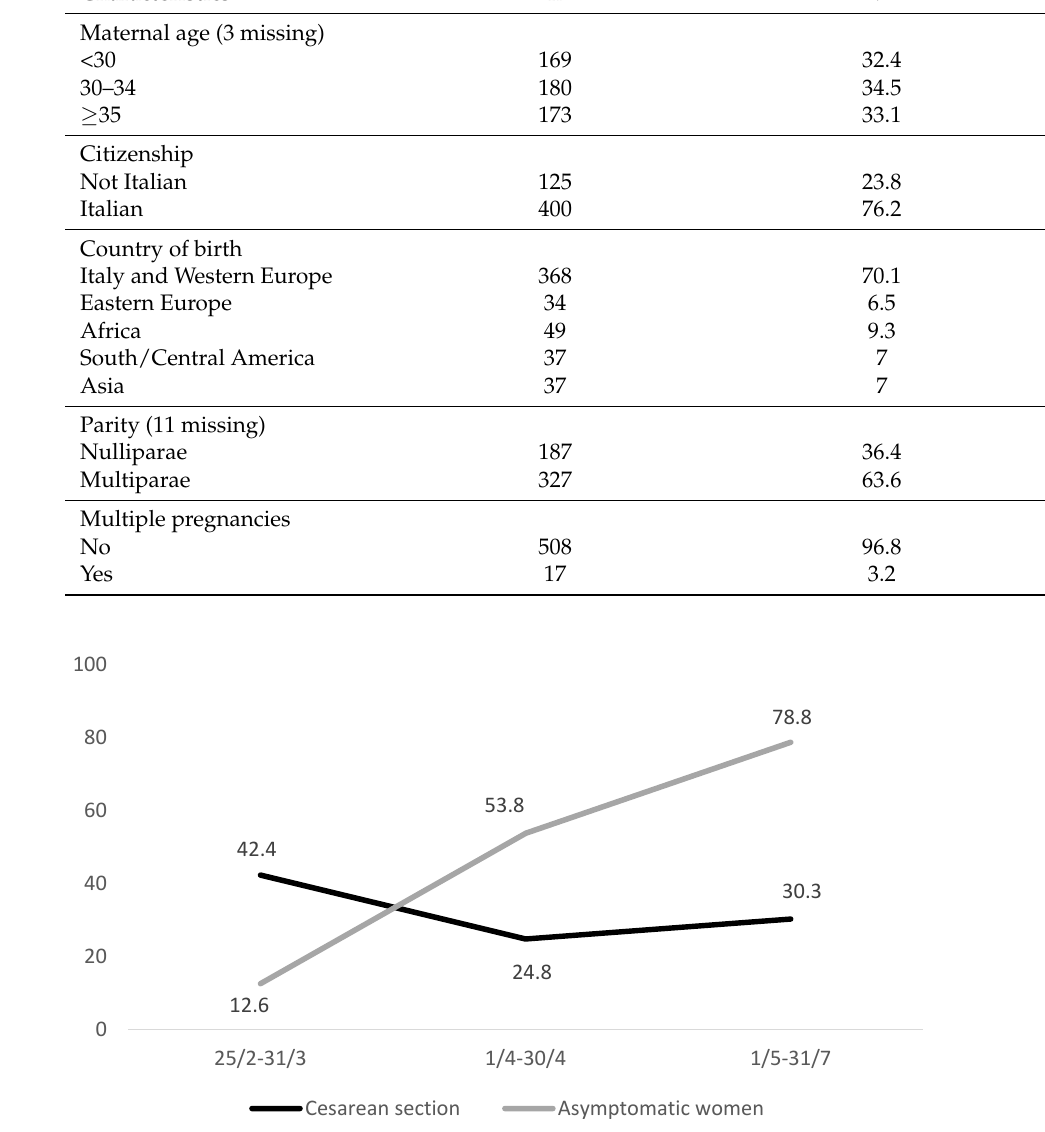
Figure 1. Temporal trend of caesarean section and percentage of asymptomatic women.